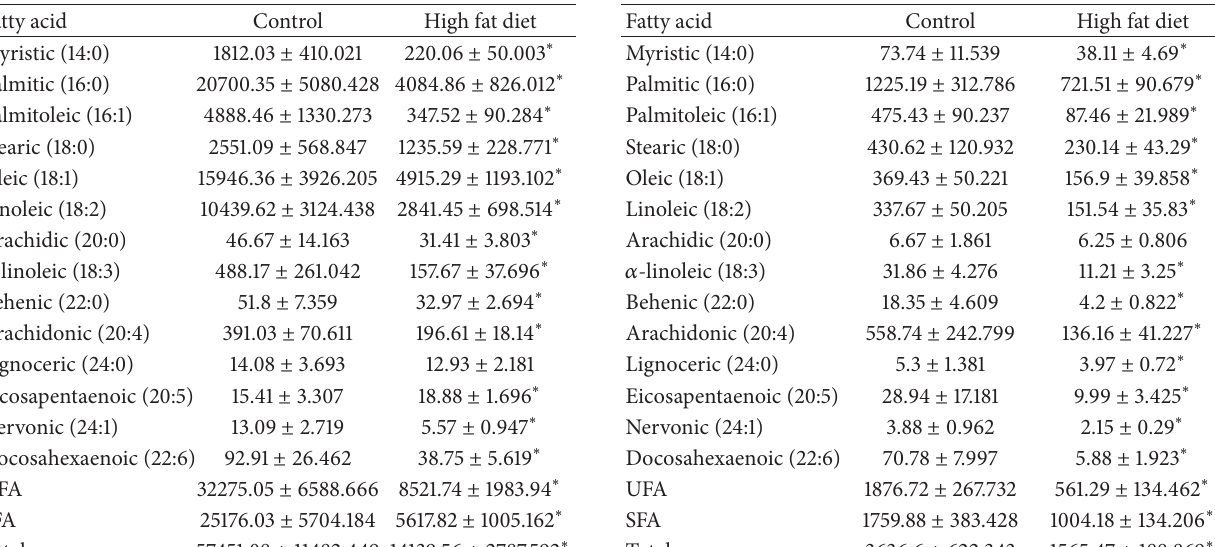
Table 3: Phospholipids composition in the submandibular salivary glands (nmol/g).